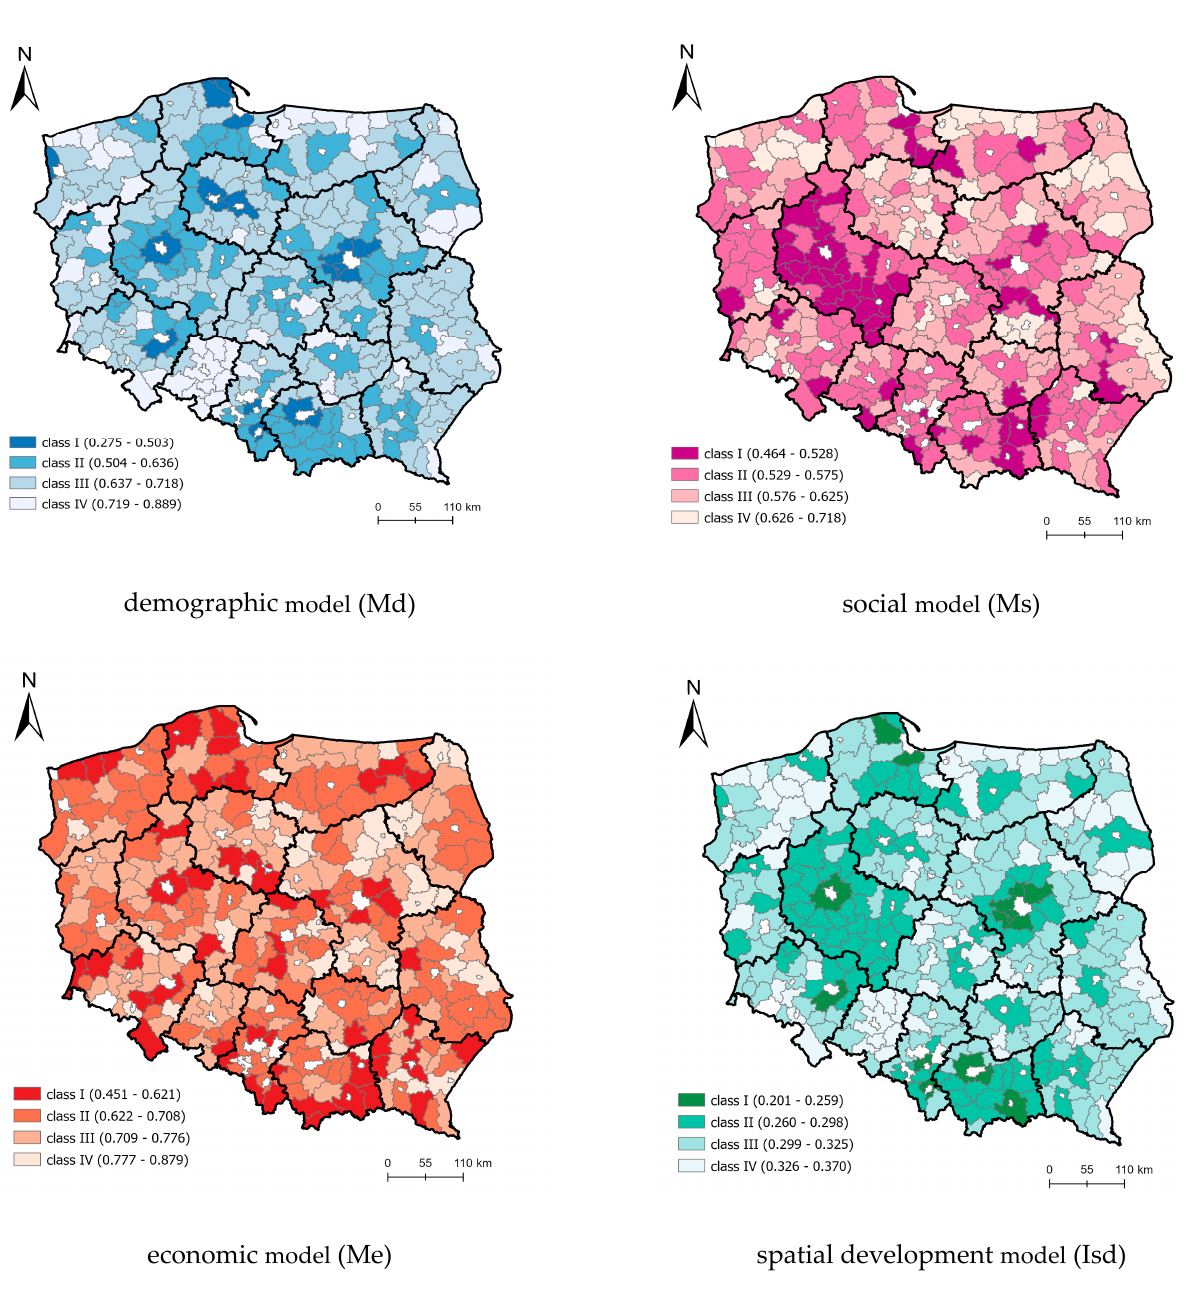
Figure 4. Spatial delimitation of component models due to the nature of factors. Source: own